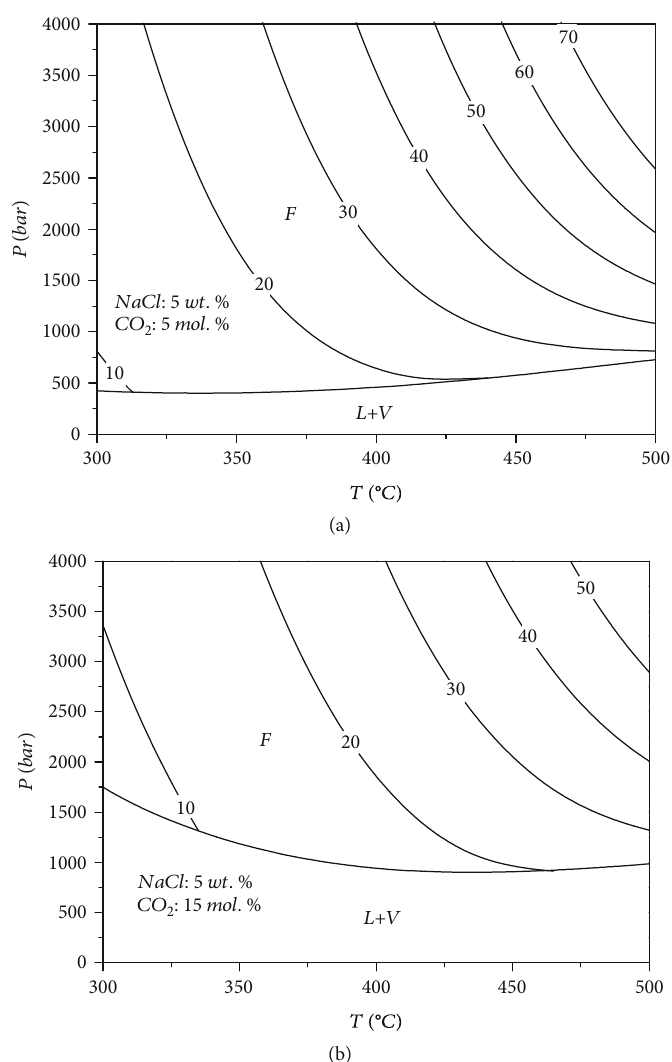
Figure 5: Quartz solubility isopleths in H O-CO -NaCl hydrothermal fl uids containing the same NaCl contents and di ff erent CO 2 2 in the single phase which are calculated from this density model and the isopleth algorithm, at 300-500 ° C and 0.01-4000bar. (a) 5 wt. % NaCl and 5mol % CO containing. (b) 5 wt. % NaCl and 15mol % CO containing. Quartz solubilities are recorded in millimoles per kilogram 2 2 H O. F : the single-phase fl uid; L + V : liquid plus vapor phase fl uid. The thin curves represent quartz solubility isopleths, and the thick 2 curves are phase